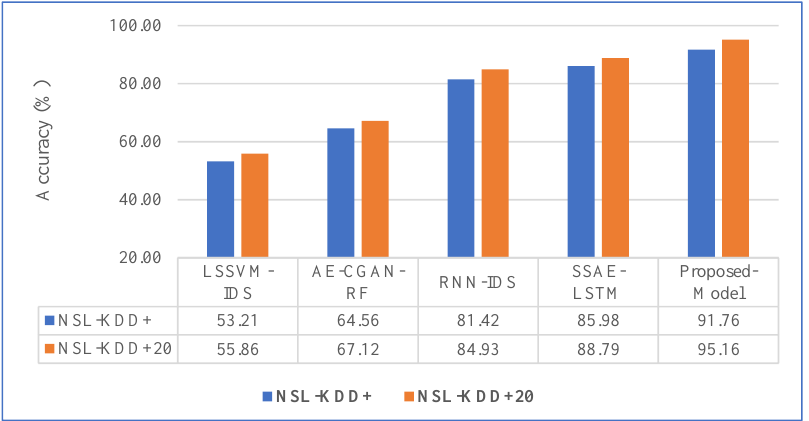
Figure 7. The performance of the proposed model with other compared models on NSL-KDD+ and NSL-KDD+20 datasets.